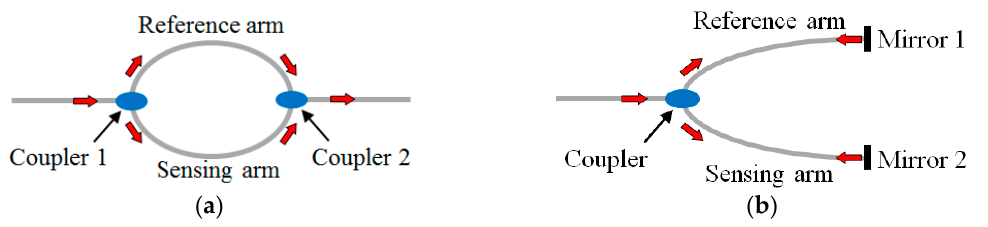
Figure 7. Illustration of Core-Cladding-Mode Interferometers (CCMIs): ( a ) Mach-Zehnder interferometer; ( b ) Michelson interferometer.